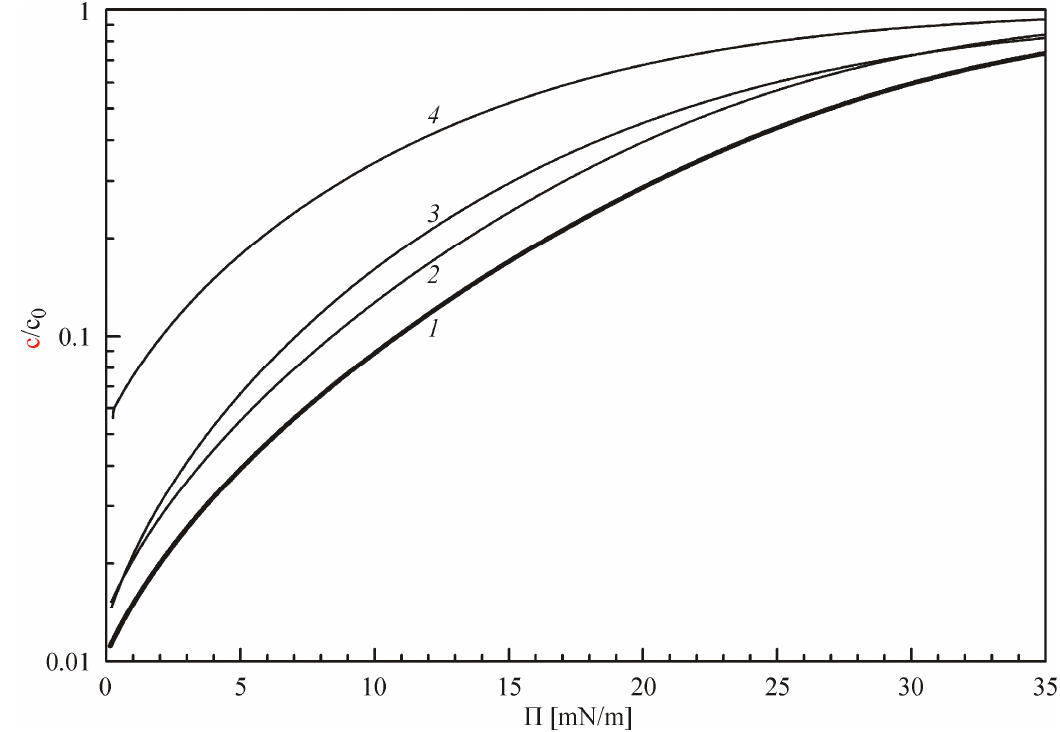
Figure 1. The dependence of the concentration ratio on surface pressure for the values of model parameters. Bold curve 1, all the parameters as shown in Table 1; thin curves, the parameters as shown in Table 1, except for: ω = 3.7 × 10 5 m 2 /mol (curve 2); a = − 2 (curve 3); S / V = 1 mm − 1 (curve 4). For more details see text.